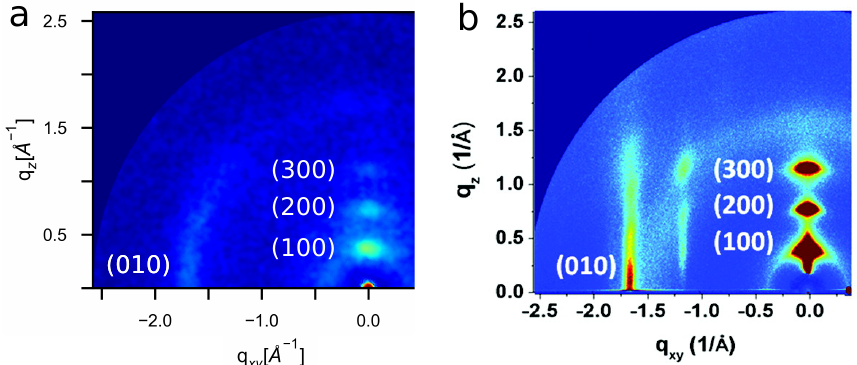
Figure 6. Our model produces ( a ) simulated GIXS patterns that closely match ( b ) experiment with π -stacking features along the (010) plane at 1.68 ± 0.02 Å − 1 and alkyl-stacking features along the (100) plane with a spacing of 0.38 ± 0.02 Å − 1 . (Experimental GIXS pattern ( b ) reprinted with permission from Ref. [74]. Copyright 2012 American Chemical